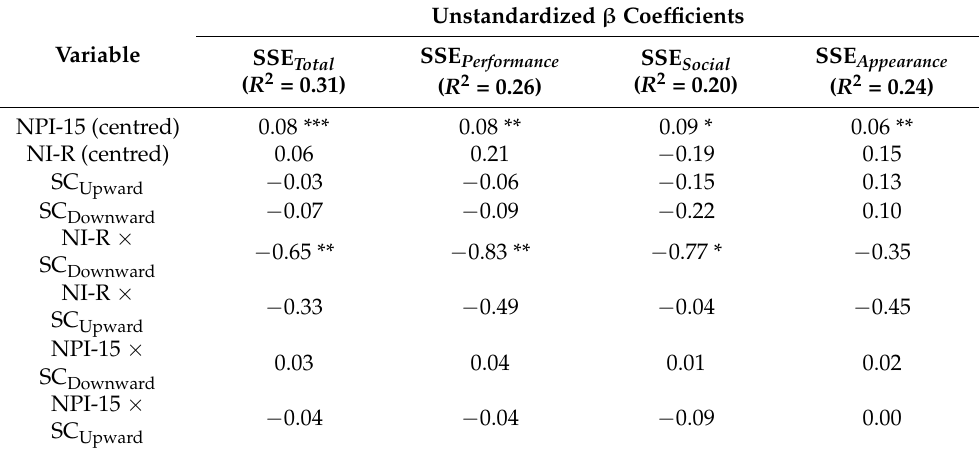
Table 3. Linear model of predictors of SSE scales.